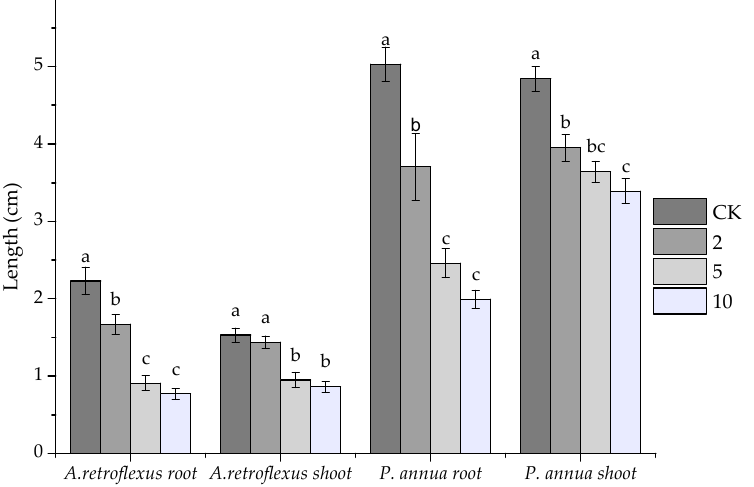
Figure 1. Allelopathic effect of volatile organic compounds (VOCs) released by fresh aerial parts of S. kaschgaricum tested at 0 g/1.5 L (CK), 2 g/1.5 L, 5 g/1.5 L and 10 g/1.5 L on root and shoot elongation of A. retroflexus and P. annua . Each value is the mean of five replicates ± SE ( n = 50). Means with different letters (a, b, c, etc.) indicate significant differences at p < 0.05 level according to Fisher’s LSD test.